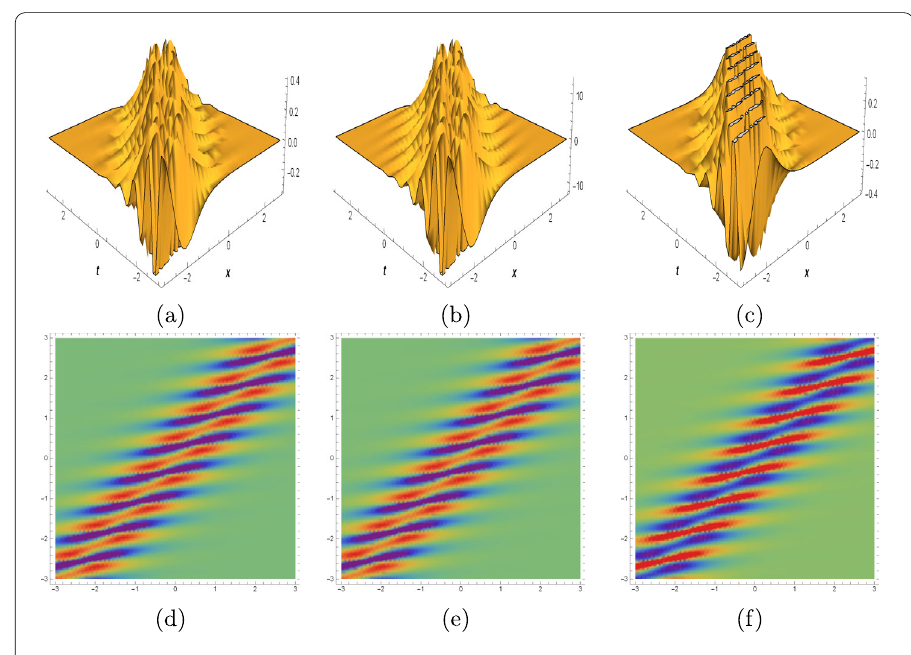
Figure 1 The 3D and density profiles of Eq. (6) for a 0 = –10, b 0 = –0.92, m 1 = 6.1